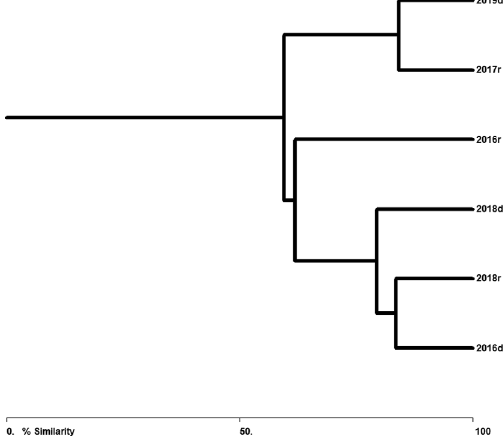
Figure 2. Similarity percentages (Bray-Curtis index) for parasite communities of Caranx sexfasciatus between sampling years. d = dry season, r = rainy